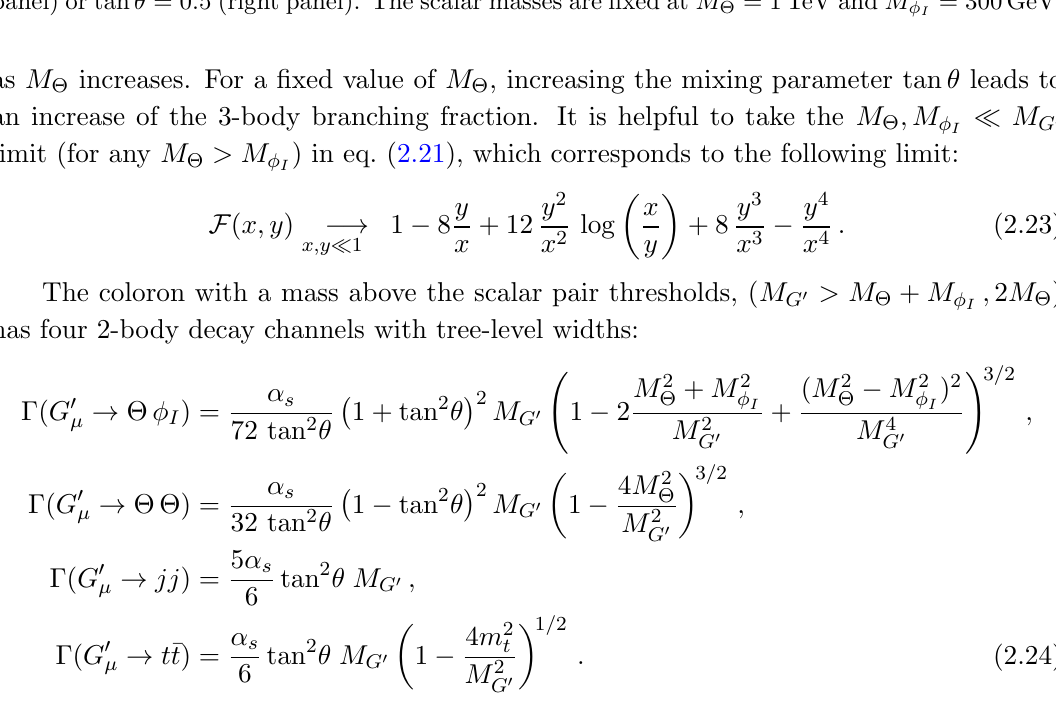
Figure 2 . Branching fractions of the coloron, G panel) or tan (cid:18) = 0 : 5 (right panel). The scalar masses are (cid:12)xed at M (cid:2) = 1 TeV and M (cid:30)